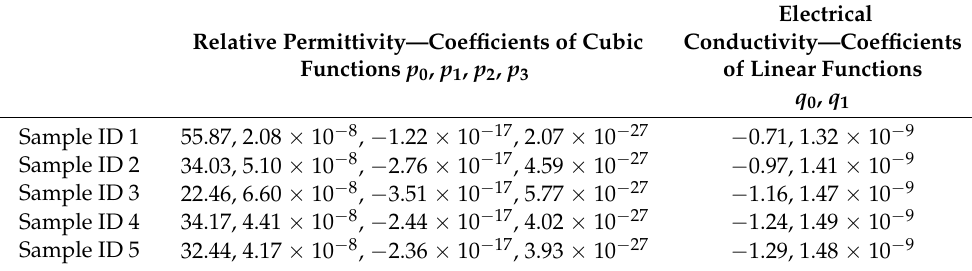
Table 3. Coefficients of relative permittivity and electrical conductivity Table 2. Dielectric parameters of individual domains of the computational area and the maximum recommended and used edge length of the discretization elements.